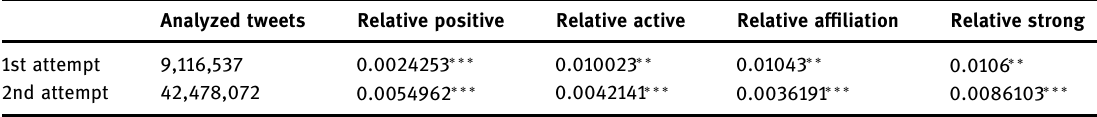
Table 3: F - statistics for the hypothesis H 0 : the changes in sentiment do not Granger cause the S&P 500 returns Analyzed tweets